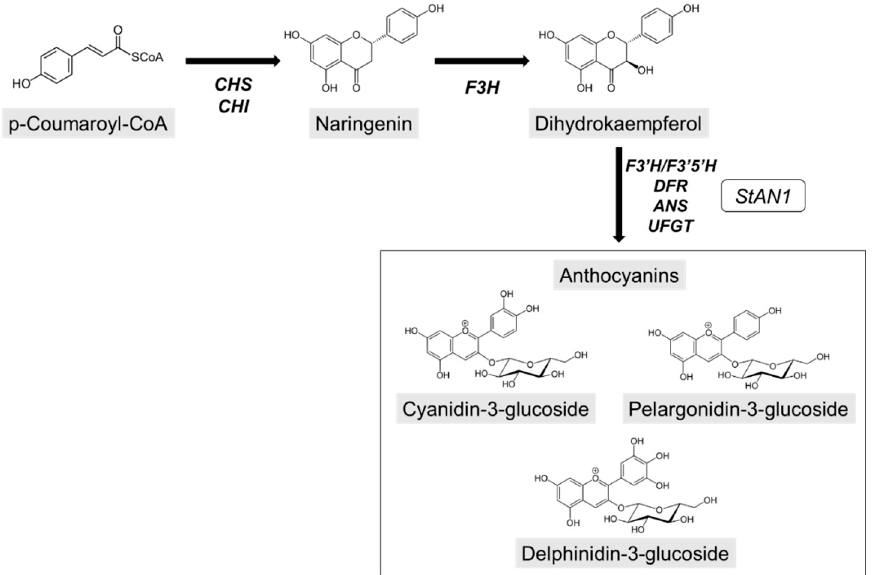
Figure 1. A simplified representation of the anthocyanin biosynthetic pathway. CHS, chalcone synthase; CHI, chalcone isomerase; F3H, flavanone 3-hydroxylase; F3 ′ H, flavonoid 3 ′ -hydroxylase; F3 ′ 5 ′ H, flavonoid 3 ′ ,5 ′ -hydroxylase; DFR, dihydroflavonol 4-reductase; ANS, anthocyanidin syn- thase; UFGT, flavonoid 3-O-glucosyltransferase. StAN1 is the transcription factor, which regulates anthocyanin biosynthesis in Solanum tuberosum .